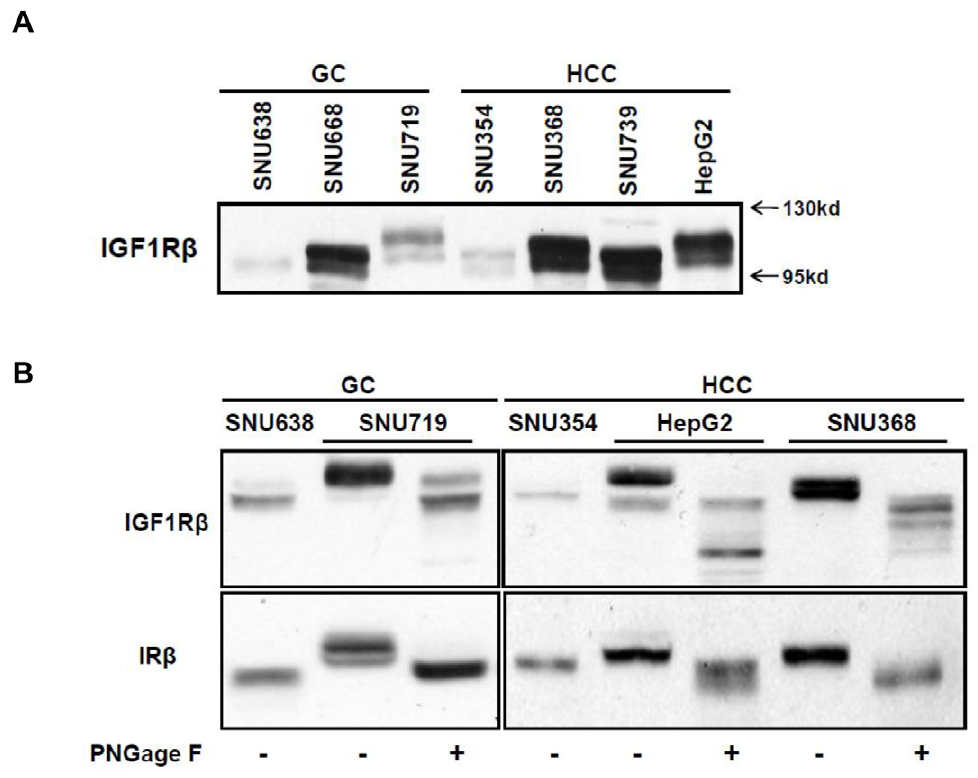
Figure 4. Analysis of NLG of IGF1R b and IR b in figitumumab-sensitive cell lines. A) Immunoblot analysis of different IGF1R b migration pattern on SDS-PAGE. Electrophoretic mobility patterns of IGF1R b were analyzed in parallel by Western bloting. Experiments were repeated at least three times with similar results. B) Analysis of N-glycosylated IR b and IGF1R b in sensitive cell lines by enzymic deglycosylation with PNGage F. All samples were incubated at 37 u C for 12 h with PNGage F. IGF1R b and IR b proteins were analyzed in parallel by Western blotting. The blots shown are representatives of three independent experiments.